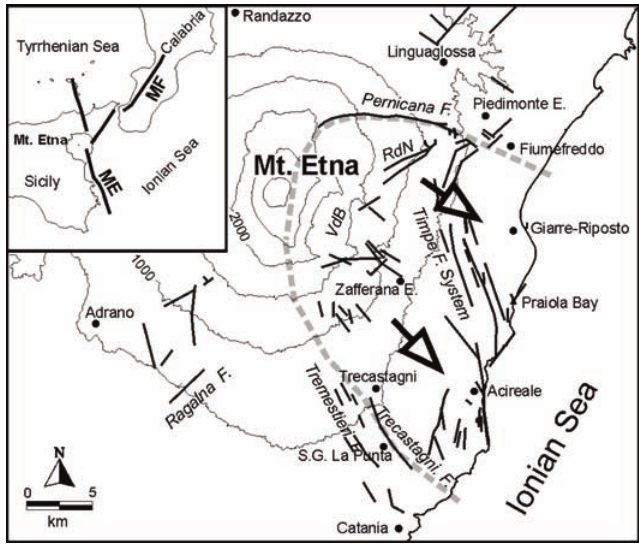
Figure 1. Surface-fault map of Mt. Etna. Inset: main regional fault systems: MF, Messina–Fiumefreddo line; ME, Malta Escarpment; RdN, Ripe della Naca; VdB, Valle del Bove. Gray line identifies the sliding sector.